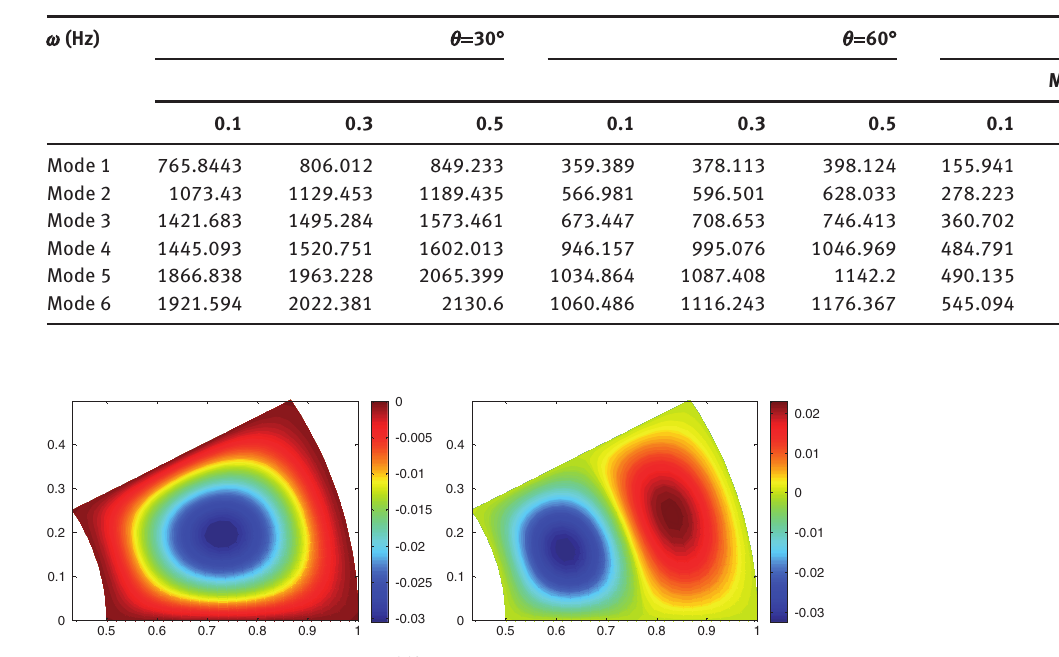
Table 5 Natural frequencies of an orthotropic FG annular sector plate clamped at the radial edges for different power-law exponents and sector angles.